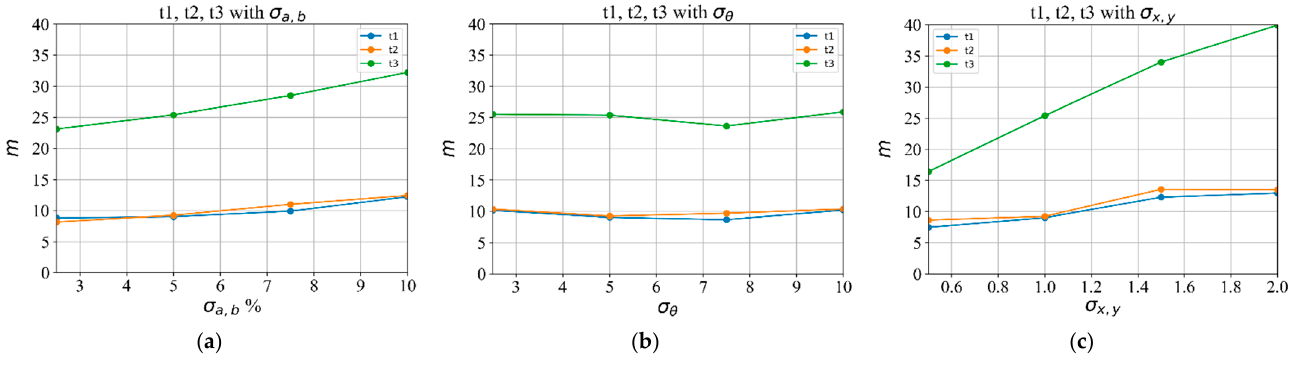
Figure 20. Position errors with noise increasing.